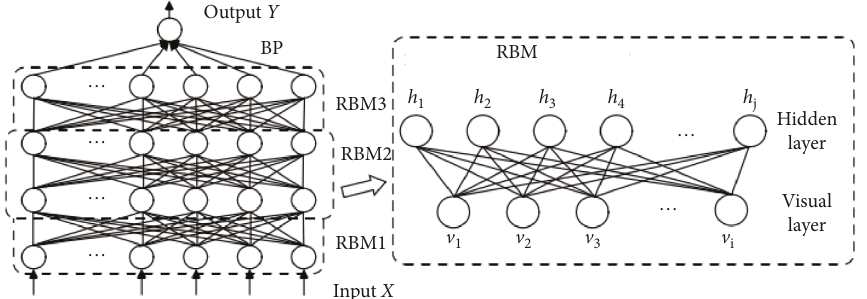
Figure 1: Structure diagram of a deep belief